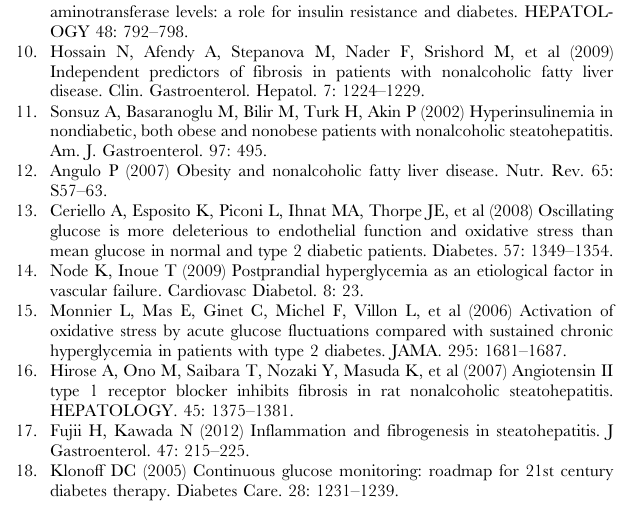
Table S2, Comparison of the clinical and physiological characteristics between the patients with F0–2 fibrosis and F3 fibrosis. Data are expressed as median 6 standard deviation. BMI, body mass index; AST, aspartate aminotransfer- ase; ALT, alanine aminotransferase; GGT, gamma-glutamyl transpeptidase; ChE, cholinesterase; T-Cho, total cholesterol; TG, triglycerides; FPG, fasting plasma glucose; Plt, platelets; Fe, plasma iron; HA, hyaluronic acid; IV collagen 7S, type IV collagen 7S; P-3-P, type III procollagen N-peptide. Table S3, Comparison of variable parameters of continuous glucose monitoring between patients with F0–2fibrosis and F3 fibrosis. Average median blood glucose: average median glucose of the patients during the 24-hour monitoring period. Average standard deviation: average standard deviation of blood glucose of the patients during the 24-hour monitoring period. Minimum and maximum blood glucose values: lowest and highest values, respectively, during the 24-hour monitoring period D Min– max blood glucose: difference between minimum and maximum blood glucose. Data are expressed as median 6 standard